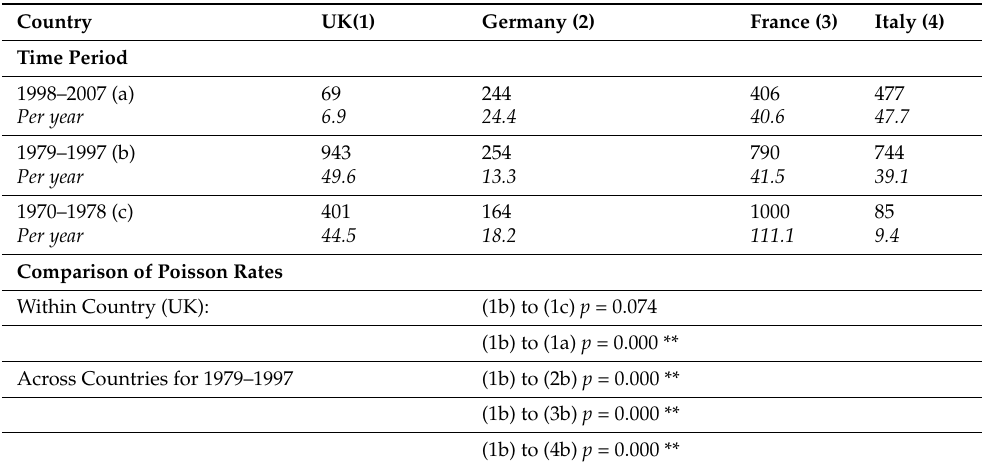
Table 2. Total and per Year Number of Fatalities from Multi-fatality Disasters, 1970–2007. Country UK(1) Germany (2) France (3) Italy (4) Time Period